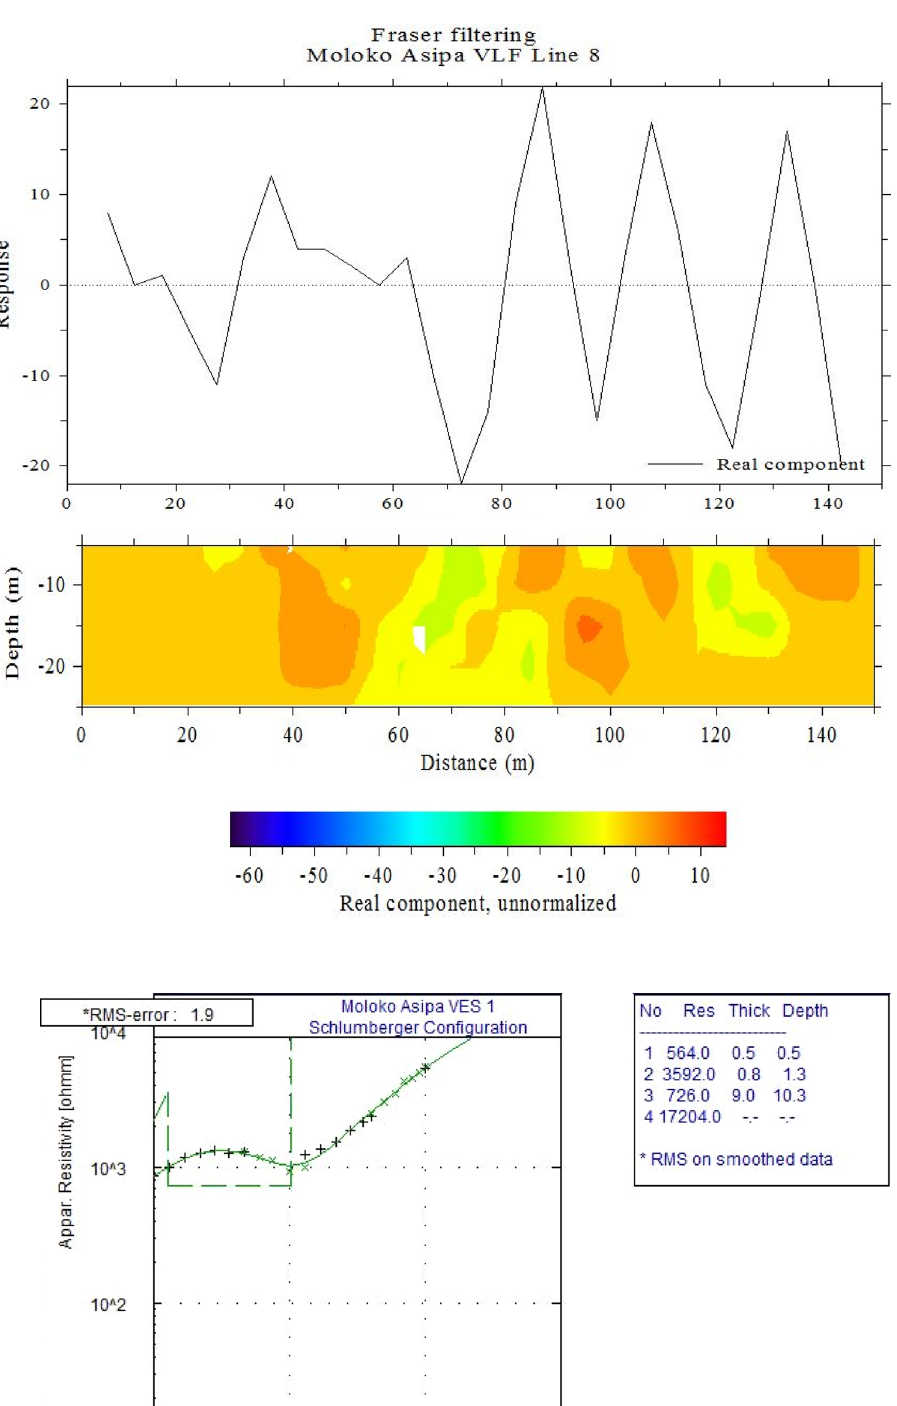
Fig. 9 Fraser and Karous–Hjelt representation for traverse 7